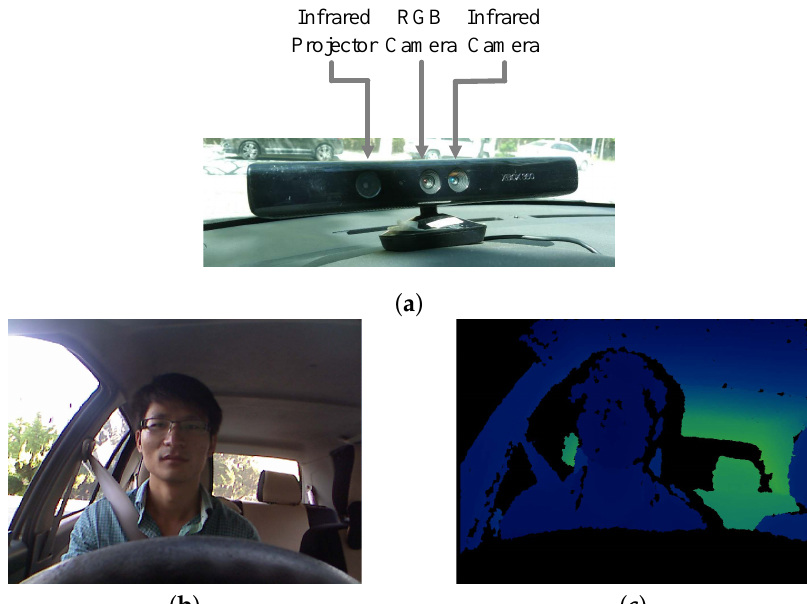
Figure 1. ( a ) Exterior appearance of RGB-D camera (Kinect v1) [4], and corresponding RGB-D data ( b , c ) obtained by